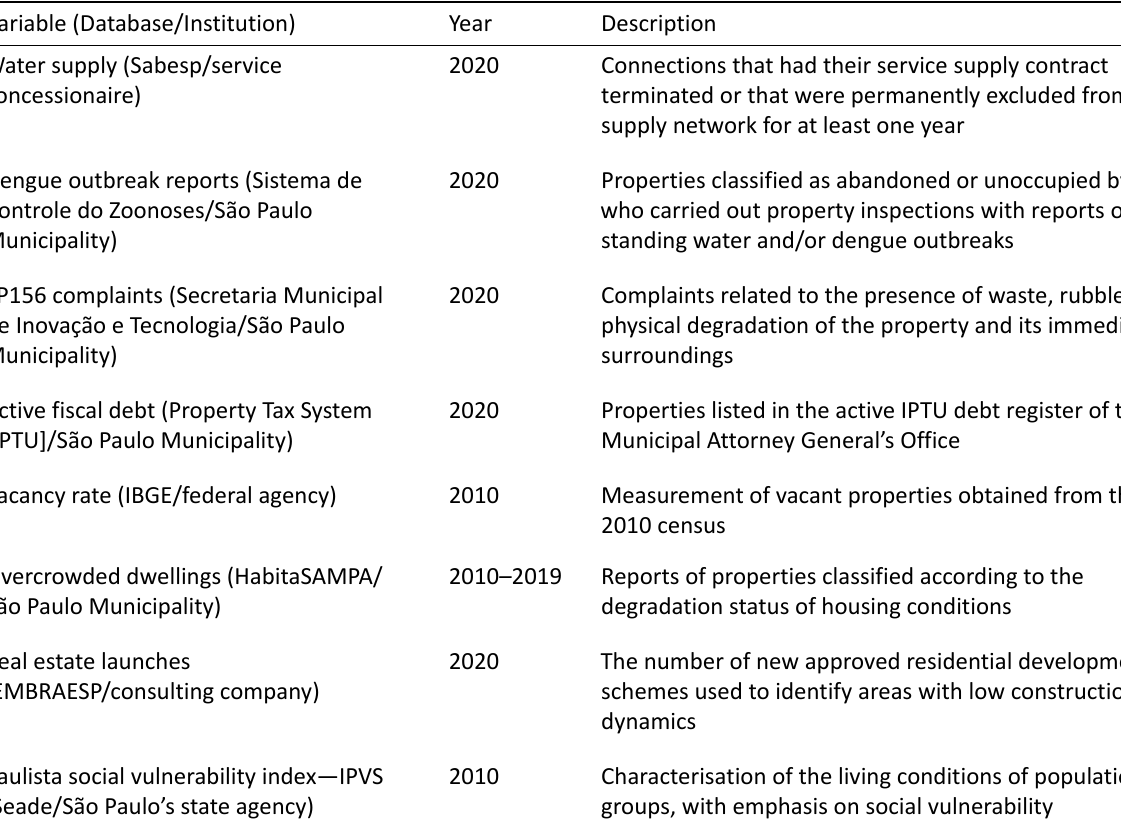
Table 1. List of variables employed in the